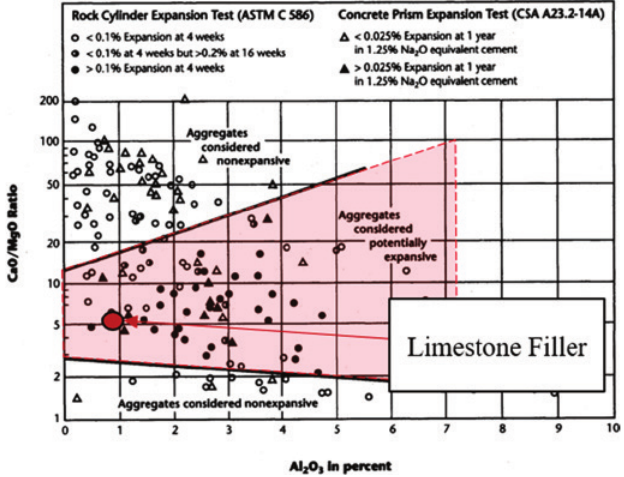
Illustration of the division between non-expansive and potentially expansive aggregates on basis of chemical composition. Source: CSA